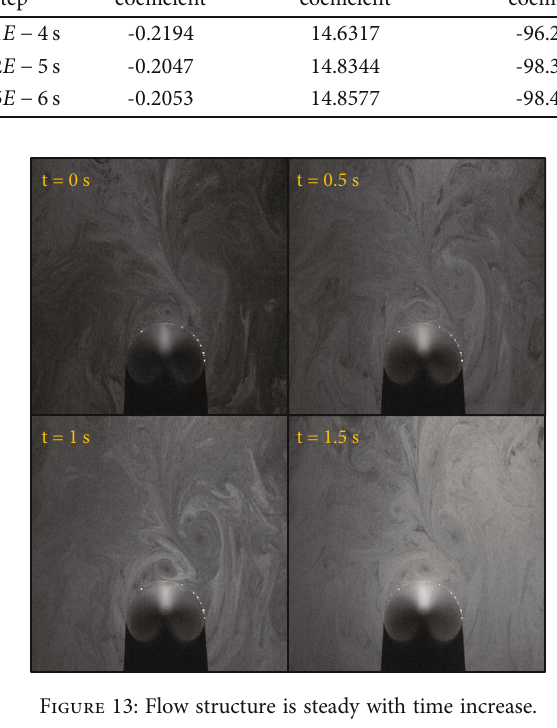
Table 5: Calculation results of aerodynamic coe ffi cients for three kinds of delta time (no bottom resistance is included). Time